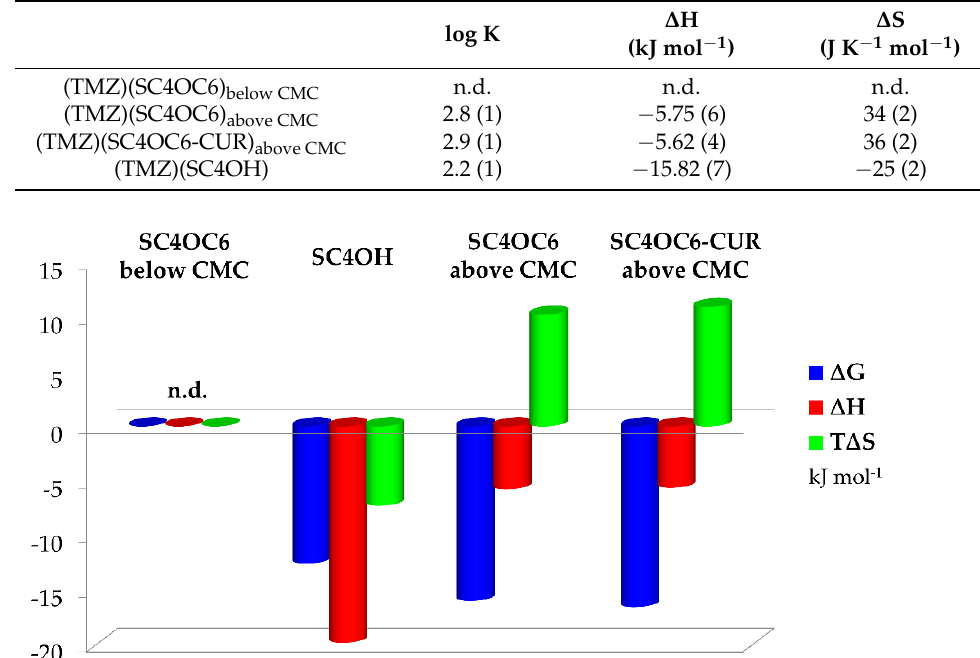
Figure 9. Thermodynamic parameters for the complex formation of TMZ with calixarene-based receptors in their monomeric or aggregated form at 25 °C in neutral aqueous buffered solution.